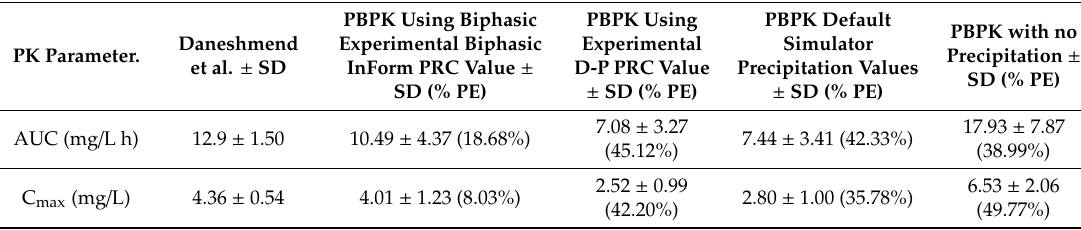
Table 5. Observed and modelled drug exposure pharmacokinetic parameters for 200 mg immediate release tablets of